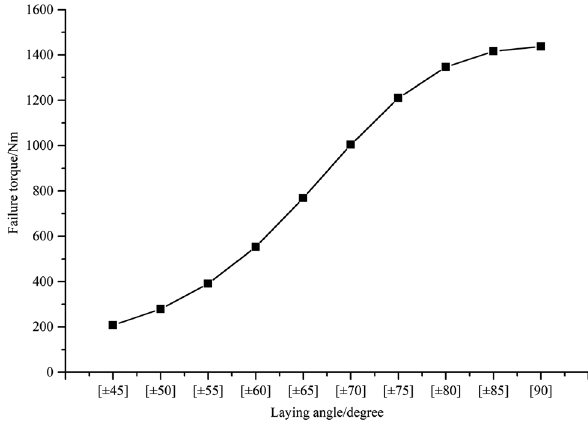
Figure 10: Relationship between failure torque and laying angles.